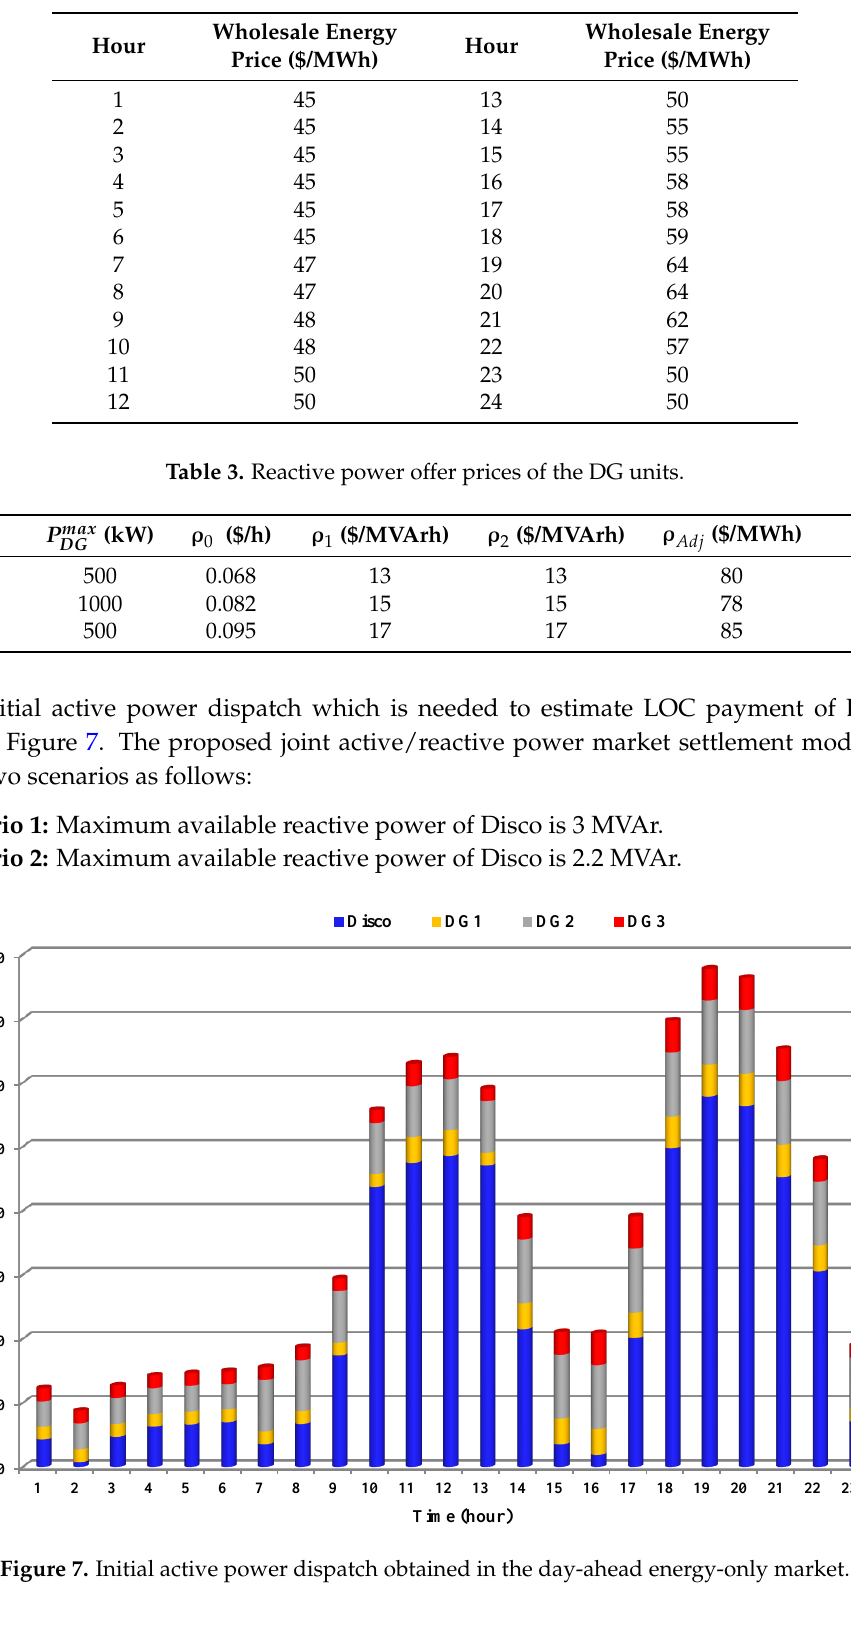
Table 2. Hourly wholesale market energy price. Table 2. Cont.